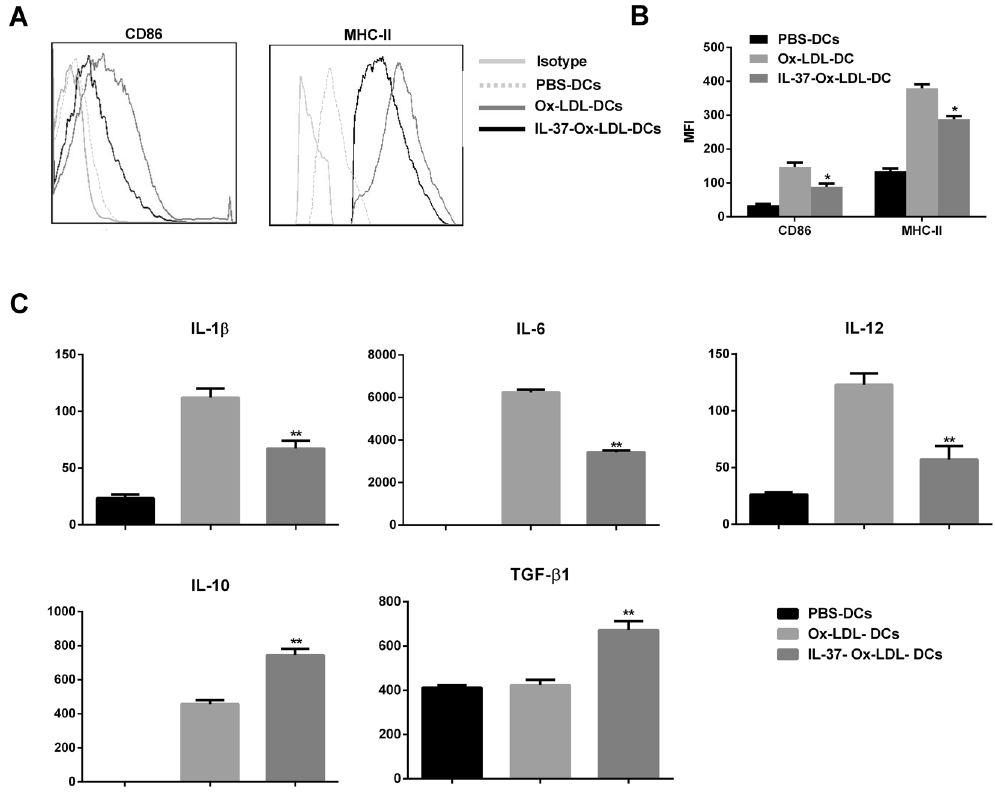
Figure 4. Effect of IL-37 on the maturation of BMDCs in vitro . ( A ) Flow cytometry results of CD86 and MHC-II. ( B ) Representative MFI of CD86 and MHC-II in the cultured BMDCs. ( C ) Results of statistical analysis of the cytokine levels in the cultured supernatant. The data represent 3 experiments in each group. Values are presented as the means ± SEM. * p < 0.05, and ** p <